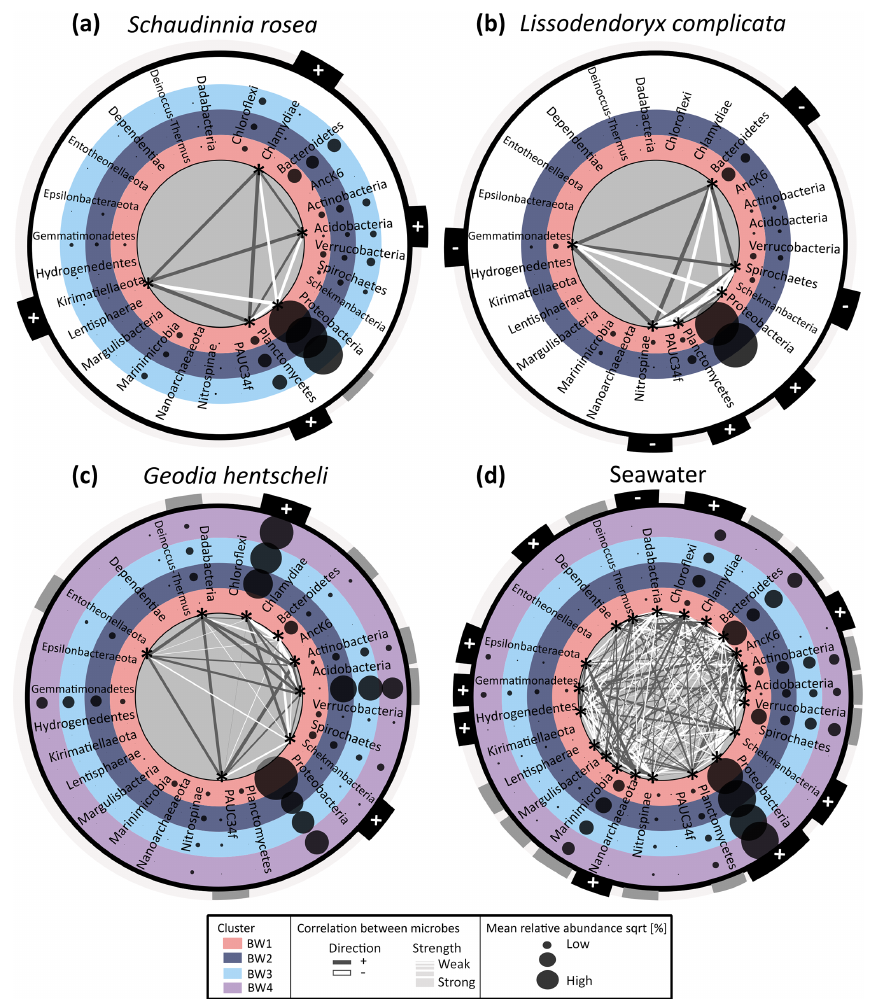
Figure 6. Co-occurrence network and differential abundance of microbial phyla across the four determined near-bed water clusters. Pan- els (a) – (c) show sponge data, with panel (a) showing average Schaudinnia rosea data, panel (b) presenting average Lissodendoryx compli- cata data, and panel (c) illustrating Geodia hentscheli data. Panel (d) contains seawater data. Near-bed water clusters are represented by differently coloured rings. Each ring contains a list with microbial phyla which are alphabetically sorted. Average relative abundances of each of the respective phyla for the samples within a given cluster are indicated by bubble sizes. Those microbial phyla which are statistically significantly enriched or depleted across the four clusters (LEfSe analysis) are marked with an asterisk inside the inner most ring. Only for those taxa where the difference is significant are correlation strength (indicated by size of connecting lines) and direction (represented by colour of connecting lines: white is negative correlation; dark grey is positive correlation) with all other significant taxa plotted. For all microbial phyla relation with depth is indicated in the outer ring of each plot by + (meaning significant positive relation) or − (meaning significant negative